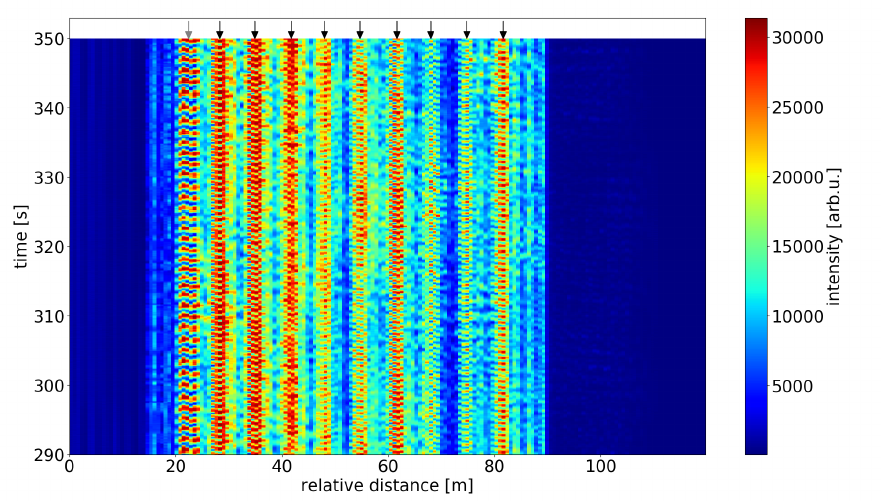
Figure 6. C-OTDR raw data along scatterer sensing fiber during heating. The black arrows mark the sensor positions used for sensing. The local patterns result from backscatter interference from pairs of consecutive scattering dots and are highly sensitive to thermal and/or mechanical excitation. The signal shown at the position indicated by the grey arrow stems from interference between the reflections from a lead-in fiber splice and the first scattering dot,